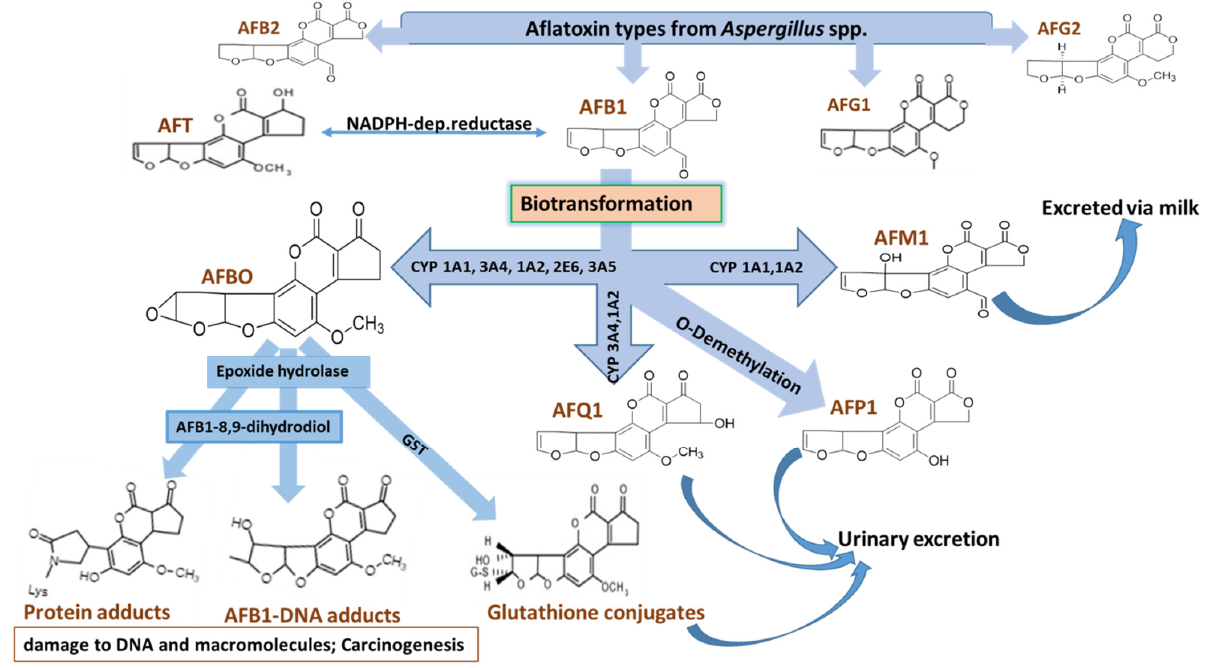
Figure 2. Major metabolic pathways and biotransformation of AFB1 (CYP: cytochromes P450). Metabolism of aflatoxins is carried out in three phases: (1) oxidation of AFB1; (2) de- toxification; (3) bacterial deconjugation.